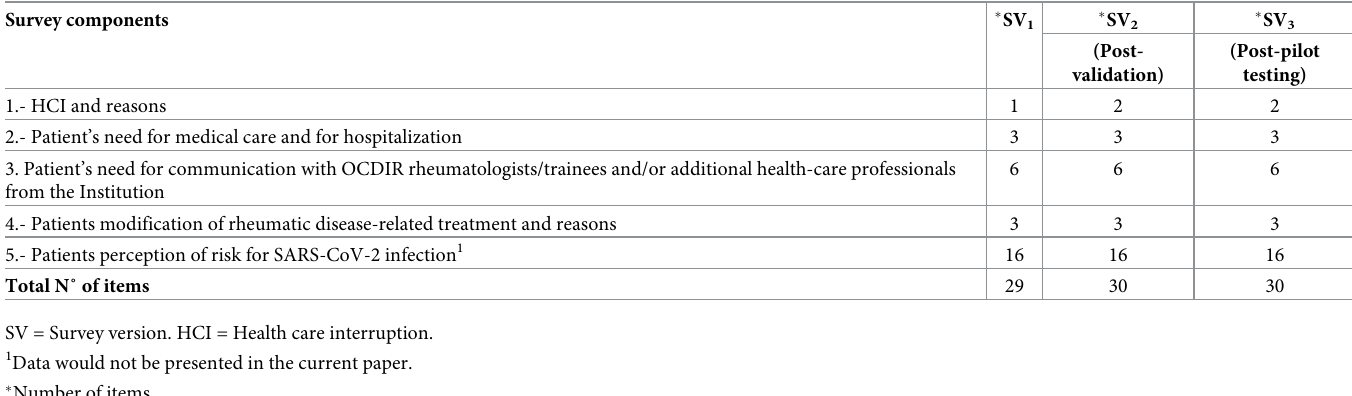
Table 1. Survey versions, components and number of items.